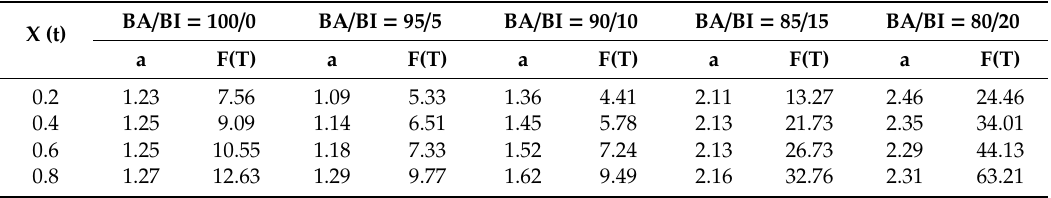
Table 5. Non-isothermal crystallization kinetic parameters of the PBABI copolyesters with di ff erent BA / BI contents obtained by Mo’s equation.